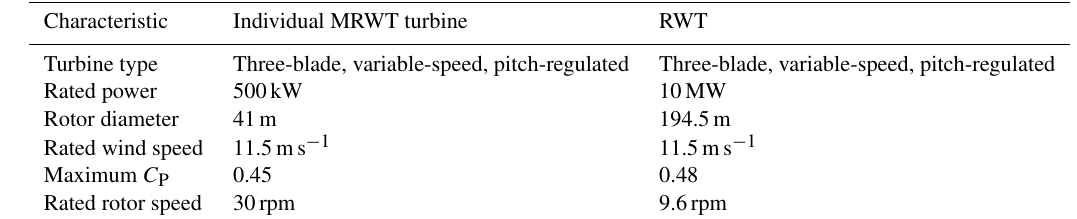
Table 1. Characteristics of each individual turbine unit used in the MRWT system and the 10MW RWT. Characteristic Three-blade, variable-speed, pitch-regulated Three-blade, variable-speed,